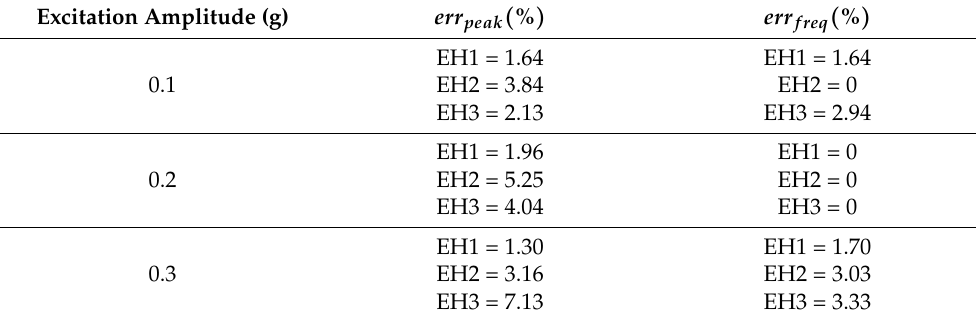
Table 7. Peak and frequency relative errors for EH1, EH2, and